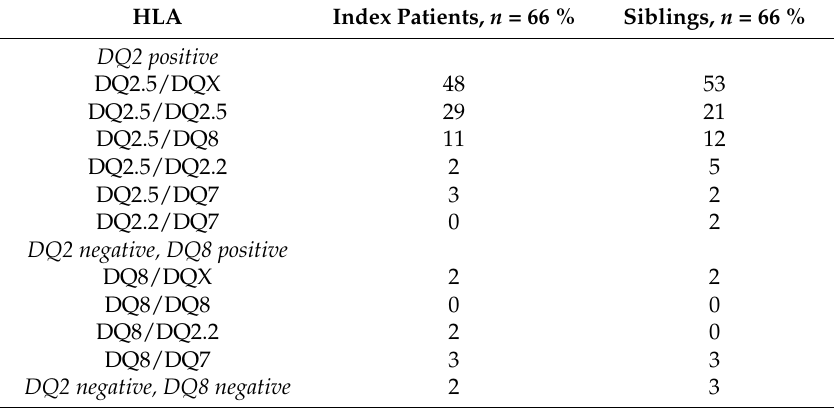
Table 3. Overall distribution of human leukocyte antigen (HLA) haplotypes in index cases and siblings with celiac disease. DQX = other than DQ2.5, DQ2.2, DQ7, or DQ8.